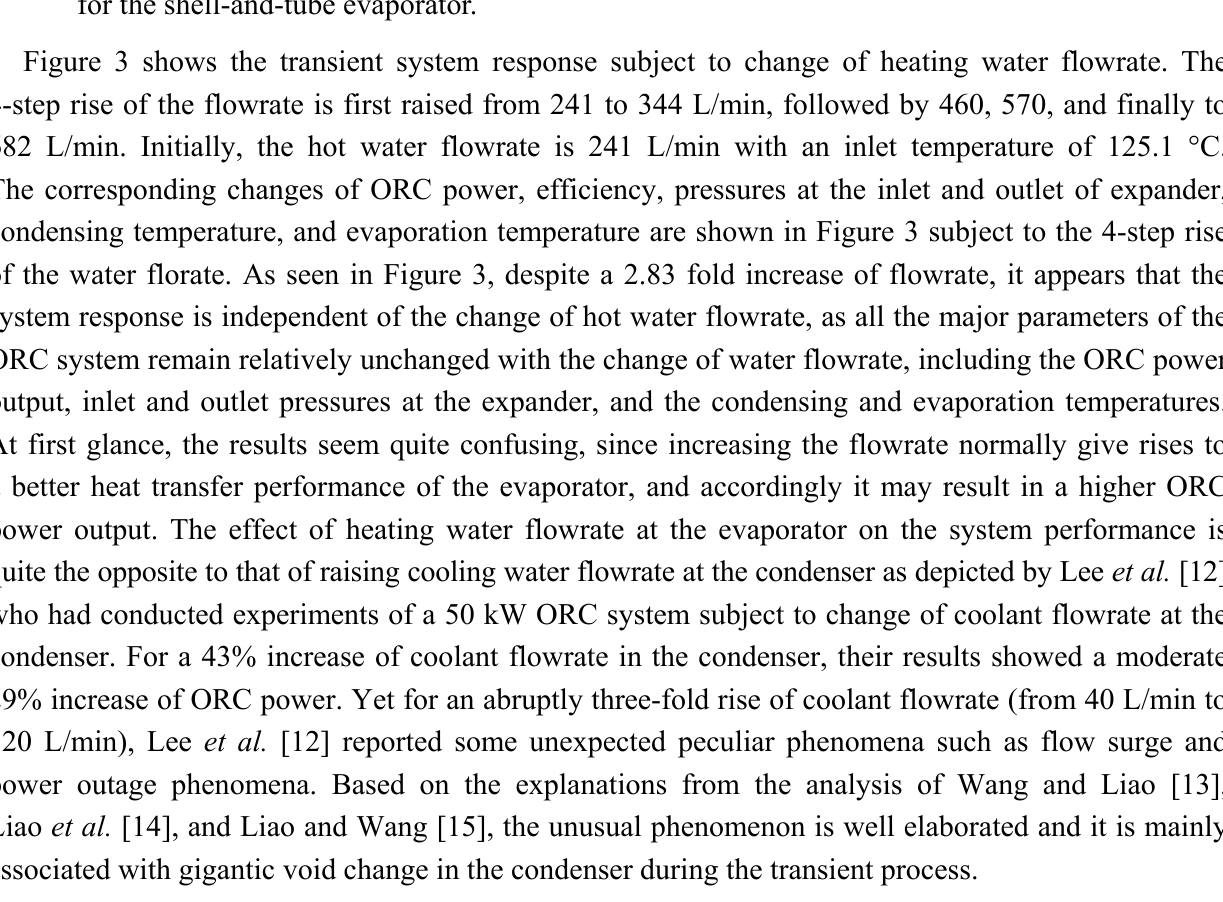
Figure 3. Transient response of the 50 kW ORC system when the subject to a 4-step change of hot water flowrate at the evaporator. ( a ) Variation of the P ( b ) Variation of the ORC power output, T : condenser temperature, T c,s